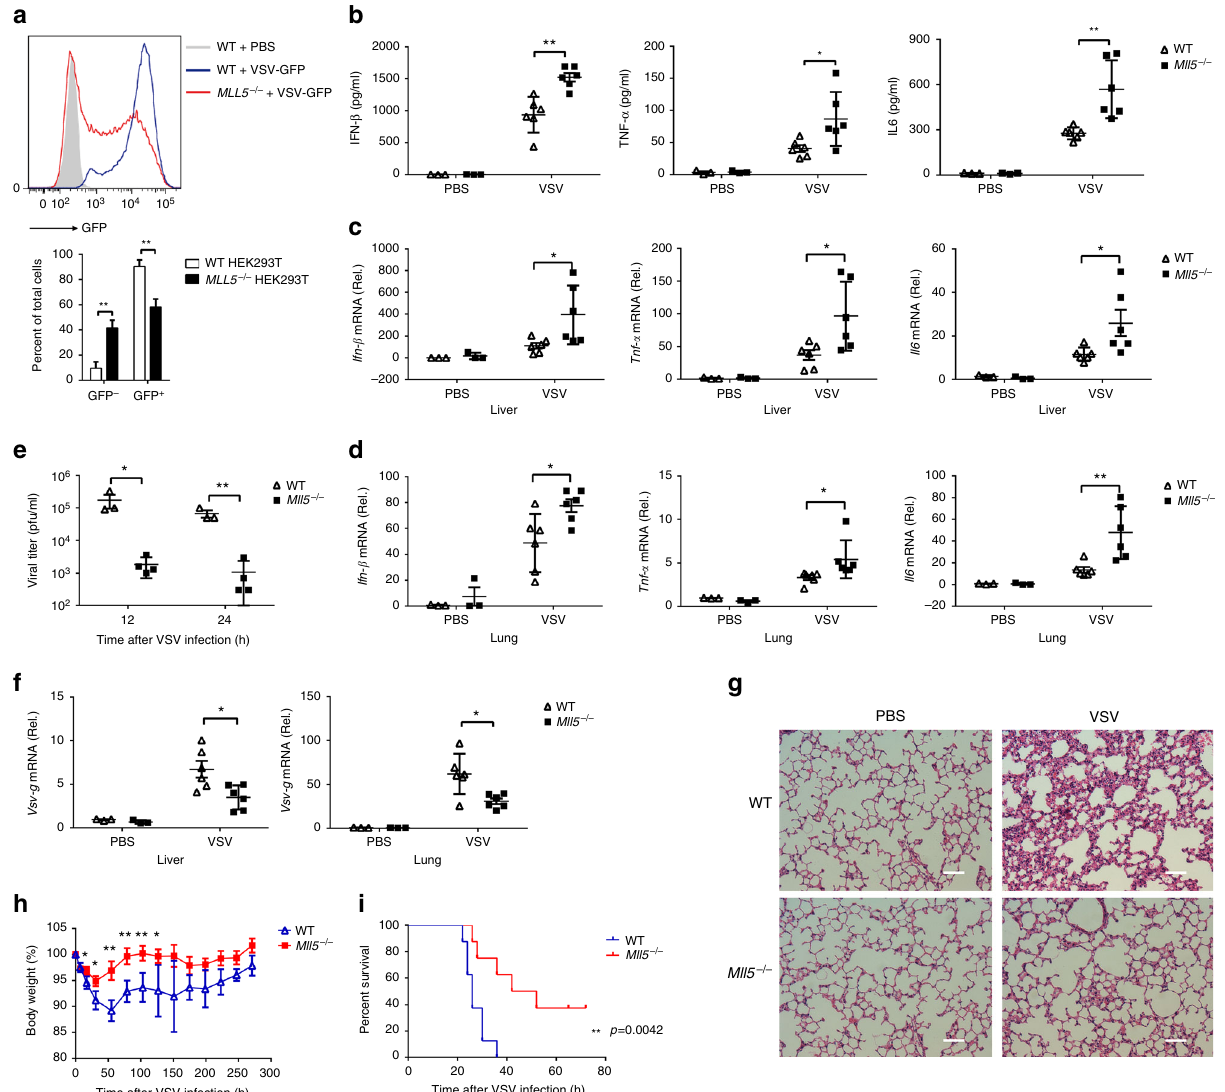
Fig. 3 MLL5 de fi ciency inhibits RNA virus replication both in vitro and in vivo. a Flow cytometry analysis of GFP fl uorescence intensity in WT (blue) and MLL5 − / − (red) HEK293T cells infected with VSV-GFP (MOI:0.1) for 20 h. WT HEK293T cells without infection served as a negative control (gray). Statistical results are shown at the bottom. b – d Six to nine weeks old WT or Mll5 − / − littermates ( n = 6) were intravenously infected with VSV-GFP (1 × 10 7 pfu/g). After 12 h, ELISA quanti fi cation of IFN- β , TNF- α and IL6 in sera ( b ). Expression of Ifn- β , Tnf- α and Il6 mRNA after infection in the liver ( c ) and lung ( d ). Gapdh served as a control. e Six to nine weeks old WT ( n = 3) or Mll5 − / − littermates ( n = 4) were intravenously infected with VSV-GFP (1 × 10 7 pfu/g), and sera were collected at 12 and 24 h after infection for plaque assay. f Expression of Vsv-g mRNA at 12 h after infection in the liver (left) and lung (right) treated as in c and d . Gapdh served as a control. g Hematoxylin – eosin staining of the lung sections from WT and Mll5 − / − mice infected with VSV- GFP (1 × 10 7 pfu/g) for 12 h. Scale bar, 200 μ m. h Six to nine weeks old WT or Mll5 − / − littermates ( n = 6) were intravenously infected with VSV-GFP (1 × 10 6 pfu/g) and monitored every 24 h after infection. i 6 – 9 weeks-old WT or Mll5 − / − littermates ( n = 8) were intravenously infected with VSV-GFP (2 × 10 7 pfu/g) and monitored every 6 h after infection. Data were representative of three independent experiments with similar results ( g ) or were from three independent experiments ( a – d , f ) or two independent experiments ( e , i ) or one experiment ( h ). Data were analyzed by Student ’ s t -test (two-tailed) or log- rank (Mantel – Cox) test and were presented as mean ± SD (* p < 0.05,** p <